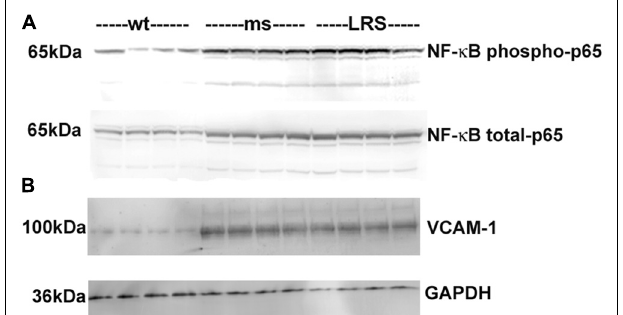
FIGURE 5 | Decrease in nuclear phospho- and total NF- κ B p65 and VCAM-1 in sickle mice overexpressing wt-FHC. (A) Nuclear extracts were isolated from livers, and 30 μ g of nuclear extract protein from each liver was run on a western blot and immunostained for phospho- and total NF- κ B p65 in wt-, ms-, and LRS-treated mice ( n = 4). (B) Microsomal membranes were isolated from livers, and 30 μ g of microsomal protein from each liver was run on a western blot and immunostained forVCAM-1.